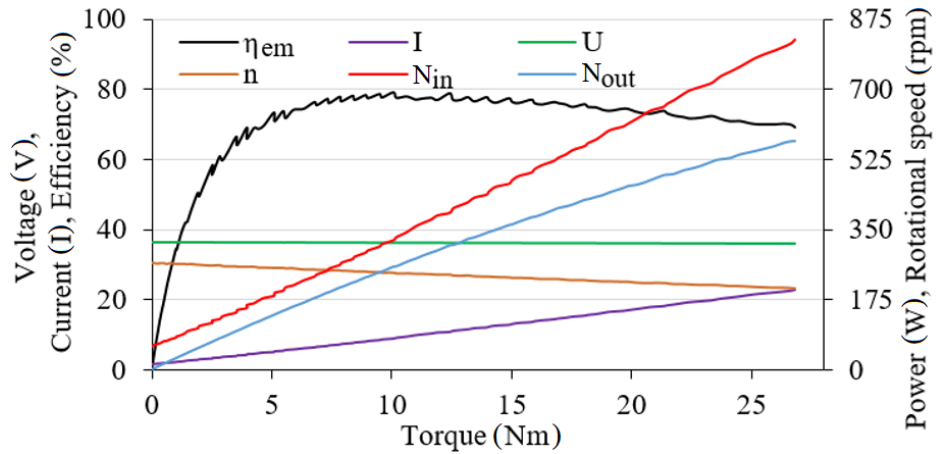
Figure 7. Characteristics of the Magic Pie 3 system by Golden Motor; based on the manufacturer’s data [53].